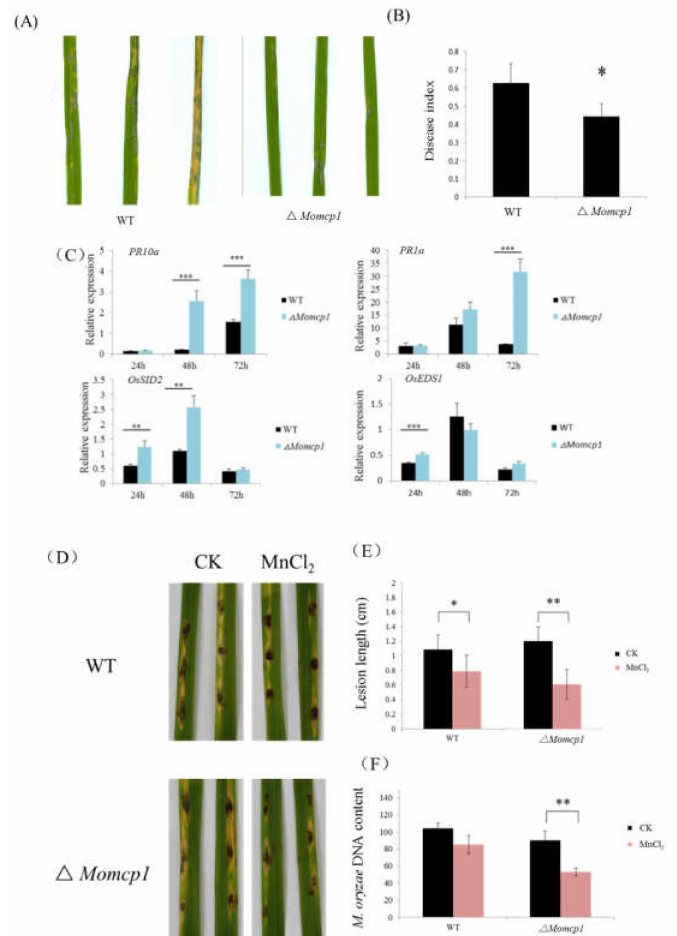
Figure 2. ∆ Momcp1 mutant showed a compromised pathogenicity to rice. ( A ) The lesions on Lijingxintuanheigu (LTH) seedlings infected by different strains. The photographs were taken at 7 dpi (day post inoculation). ( B ) The disease indexes were obtained from 3 times and more than 30 seedlings were counted each time. The significant difference was determined by a t -test; *, p < 0.05. ( C ) The expression levels of the defense related genes at 24, 48, and 72 hpi after each strain inoculation on LTH. The experiments were repeated three times. The significant differences determined by a Tukey’s honestly significant difference (Tukey-HSD) test; **, p < 0.01; ***, p < 0.001. ( D ) Punch inoculation of each strain on the detached leaves. The detached leaves were wound by ear needle, and the conidia suspensions added or not added with 2mM Mn 2+ were dropped on the wound. The pictures were taken at 7 dpi. ( E ) The length of the lesion was measured at 7 dpi. ( F ) Fungal biomass was calculated at 7 dpi. The significant difference was determined by a t -test; *, p < 0.05; **, p <